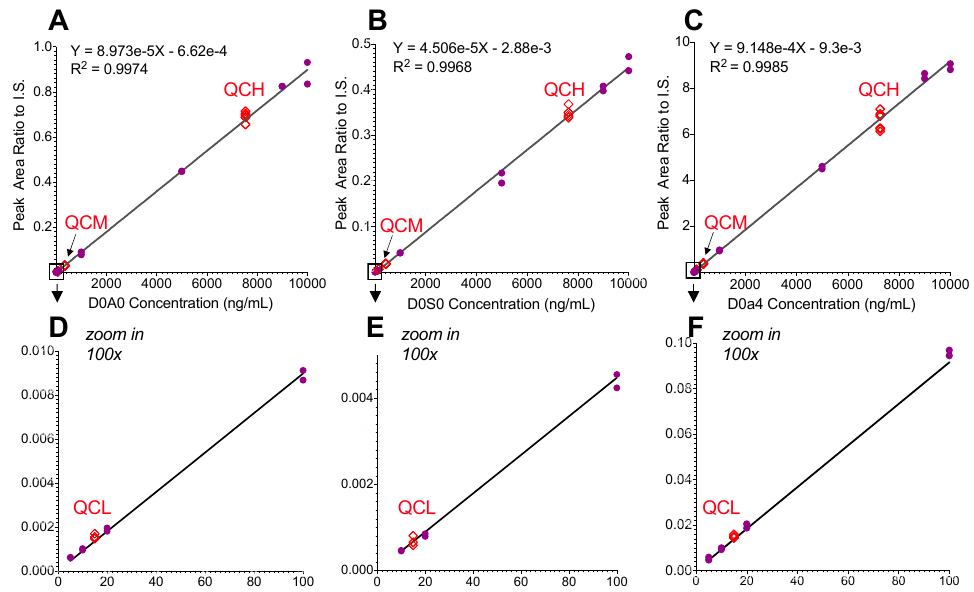
Figure 3. Calibration curves for D0A0, D0S0 and D0a4 based on the ratio of peak area to I.S. area using undigested human CSF as matrix. ( A – C ) Dynamic range 5–10,000 ng / mL, ( D – F ) inset for dynamic range 5–100 ng / mL. I.S. concentration 20 ng / sample. GAG concentration levels: 5, 10, 20, 100, 1000, 5000, 9000 to 10,000 ng / mL. QCH = 7500 ng / mL, QCM = 300 ng / mL, QCL = 15 ng / mL. Total QCs n = 6. Three (3) µ L of standard solutions were used to mimic the mouse CSF sample preparation procedure. Table 1. Fit-for-purpose qualification results for Heparan and Dermatan Sulfate Disaccharides in CSF for calibration curves in Figure 3. Parameter Qualification